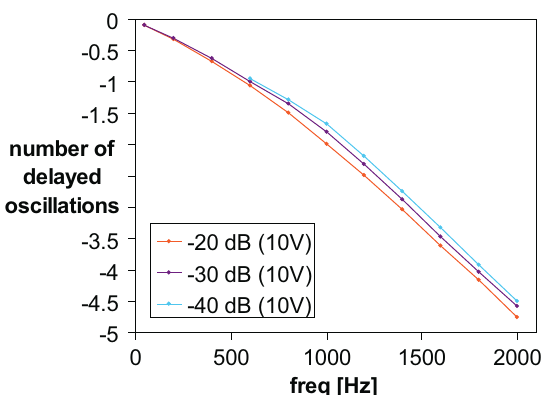
Figure 7 . Response phases for different stimulus levels ( µ = − 0 . 05 , central frequency: 1480 Hz, section 5). The dependence is similar to the biological measurements reported in